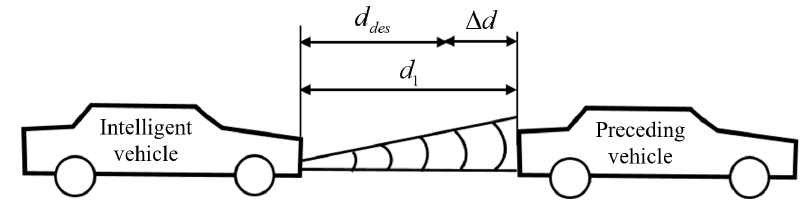
Figure 2. Longitudinal following on straight